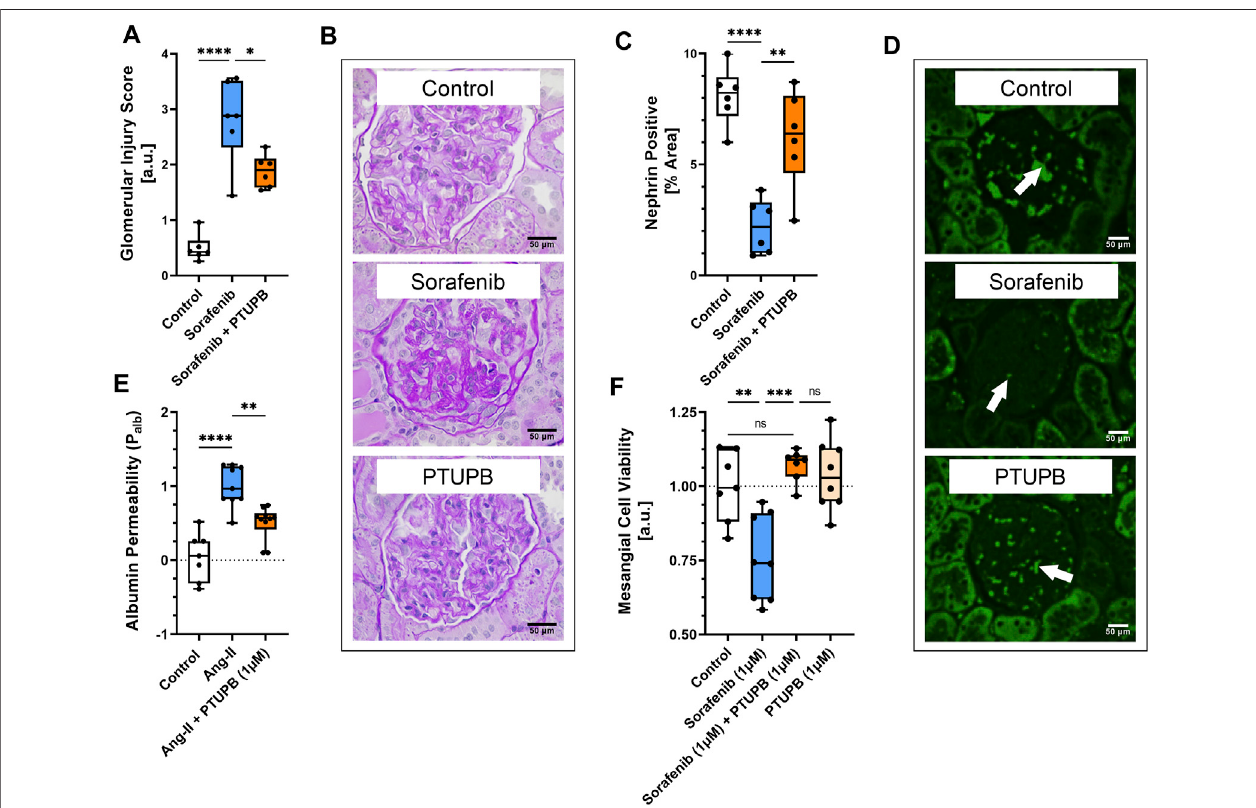
FIGURE5| Glomerularinjury.Glomerularinjuryresultedfromsorafenib-treatment(bluebar).PTUPBcotreatmentimprovedglomerularhistologicalfeatures(orange bar) (A) . Representative images of fi brotic changes (PAS staining) (B) . Nephrin loss was evident in sorafenib-treated glomeruli (blue bar). PTUPB mitigated nephrin loss (orange bar) (C) . Representative images of nephrin changes in glomeruli (IF, nephrin stain). White arrows point to nephrin-positive areas (D) . PTUPB mitigated Ang-II- induced glomerular permeability (orange bar) (E) . PTUPB rescued mesangial cells from sorafenib cytotoxicity (F) . (A – D) n (cid:1) 4 – 6 rats/group. Dots represent the averageofduplicatemeasuresforeachindividualrat. (E) n (cid:1) 7 – 10glomerulifromfourrats. (F) n (cid:1) 7 – 8.Dotsrepresenttheaverageofduplicatemeasuresforeachwell.ns p > 0.05,* p ≤ 0.05,** p ≤ 0.01,*** p ≤ 0.001,**** p ≤ 0.0001determinedbyANOVAfollowedbytheTukey post-hoc test.Dataarereportedasboxandwhiskerplotswith median, minimum to maximum, and 10 to 90